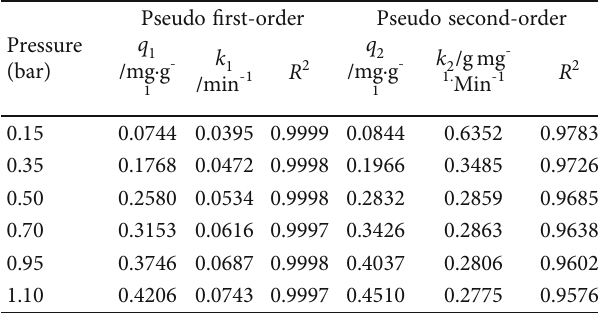
Figure 10: Dynamic curves of HF under di ff erent pressures at Table 2: The fi tting kinetic parameters for PFO and PSO.